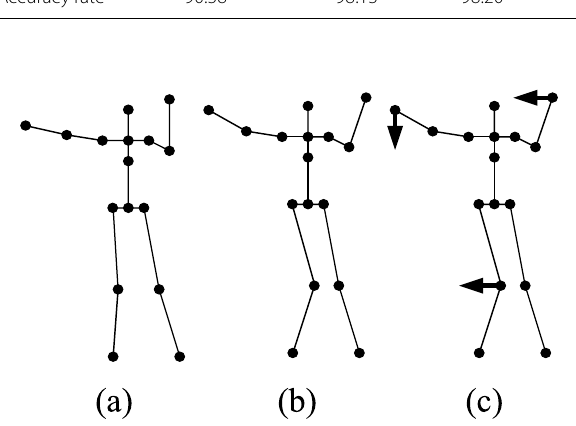
Fig. 11 Dance action correction